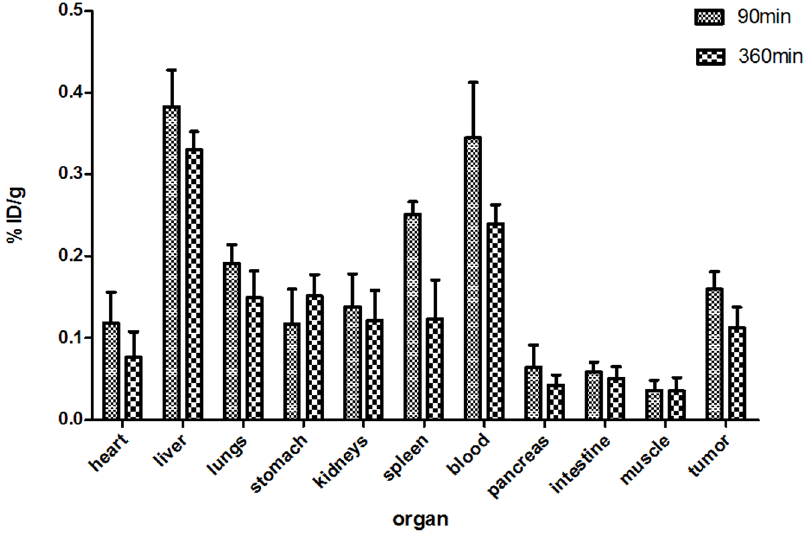
Figure 4. Histograms of the %ID/g for various organs of nude mice at 90 min and 360 min after an injection of 125 I-liraglutide. At 90 min, the radioactivity was highest in the liver and blood, followed by the spleen, lungs, tumour, kidneys, heart, and stomach. The radioactivity was relatively low in the pancreas, small intestine, and muscle tissue. The tumour tissue exhibited higher levels of radioactivity than the kidney or the heart. At 360 min, the radioactivity had decreased to various degrees for all examined organs except for the stomach. Data are expressed as average %ID/g 6 SD(N=3).